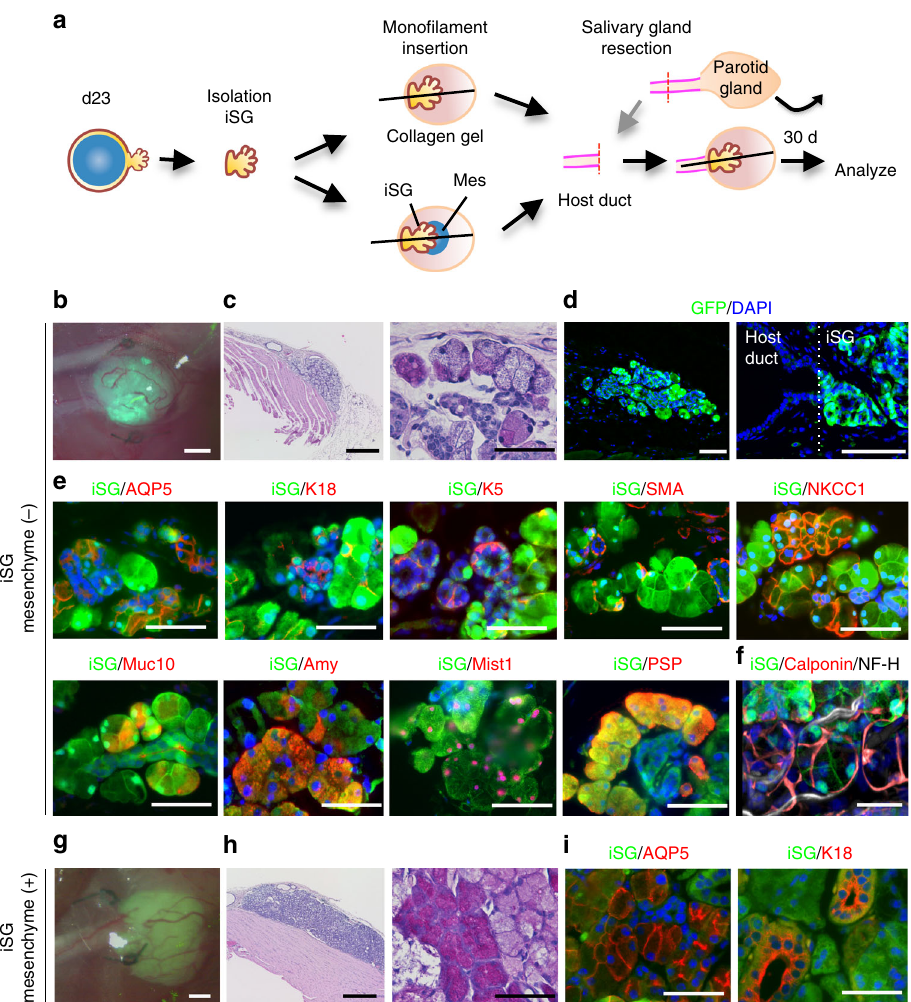
Fig. 4 Orthotopic transplantation of induced salivary glands. a Schematic representation of the protocol for the orthotopic transplantation of iSGs into mice with defective parotid glands. b Photograph of GFP-labelled iSG transplants in salivary gland-defective mice on day 30 after transplantation. Scale bar, 500 μ m. Representative image from one out of more than 10 times of transplantation are shown. c Haematoxylin and eosin (H&E) staining of the transplantation site (left), and a high magni fi cation image of periodic acid-Schiff (PAS) staining (right). Scale bars, 500 μ m (left) and 50 μ m (right). d Fluorescence images of the transplantation site. Most GFP-positive cells formed gland-like structures (left). Higher magni fi cation image showing the duct connection between the host duct and the duct of the iSG (right). Scale bar, 200 μ m. e Immuno fl uorescence staining of the salivary gland-speci fi c markers AQP5, K18, K5, α -SMA, NKCC1, Muc10, Amy, Mist1, and PSP. Scale bars, 50 μ m. f Fluorescent images are projections of 50 μ m sections. Merged images of GFP (green), calponin (red), and neuro fi lament H (NF-H) (white) are shown (right). Scale bars, 50 μ m. g Photographs of GFP-labelled iSGs transplanted with mesenchymal cells in parotid gland-defective mice on day 30 after transplantation. Representative image from one out of more than 30 times of transplantation are shown. Scale bar, 500 μ m. h H&E staining (right) and PAS staining (right) of the engrafted iSG with mesenchyme. Scale bars, 500 μ m (left), 50 μ m (right). i Immuno fl uorescence staining of the engrafted iSG with mesenchymal cells salivary gland-speci fi c markers AQP5 and K18. Scale bars, 50 μ